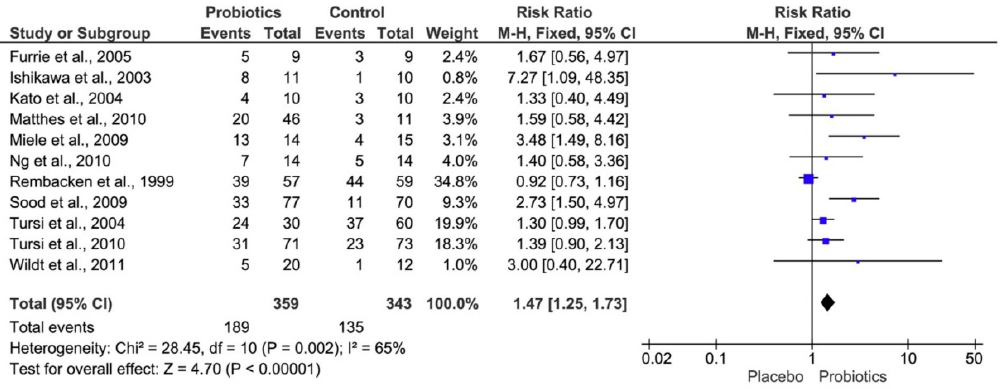
Figure 8. Forest plot showing the effect of probiotics on inflammatory bowel diseases (IBD) [21].